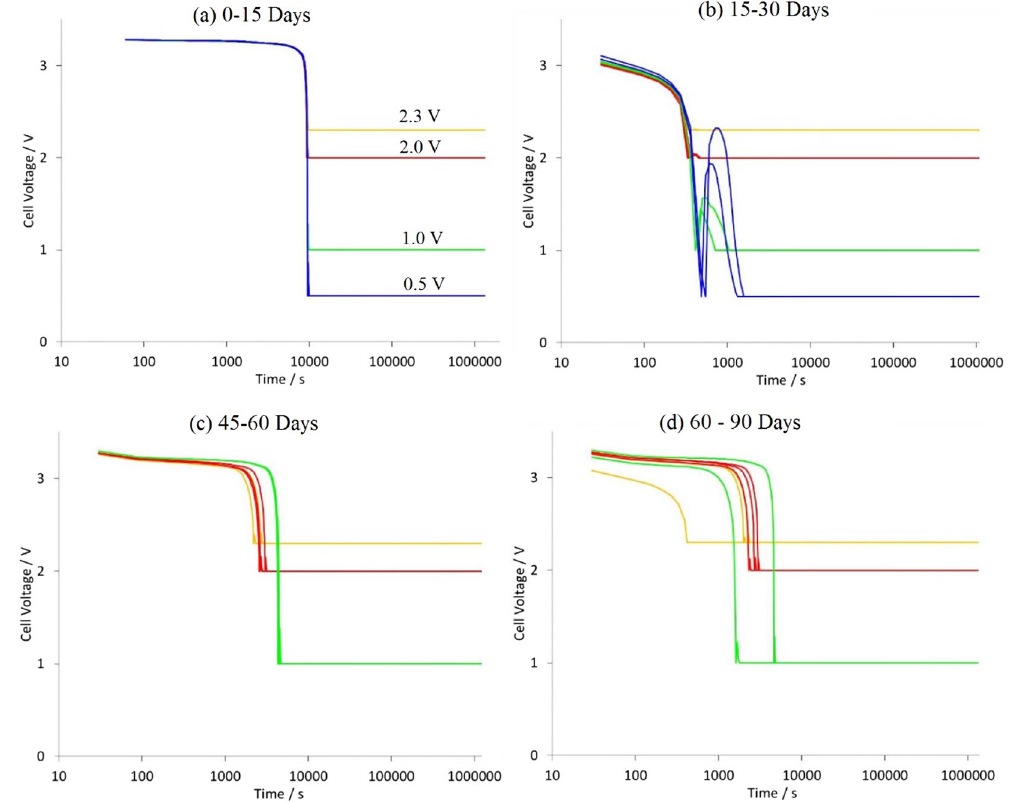
Figure 1. Discharge voltage and constant voltage storage for all cells. Cells stored at 0.5 V became dysfunctional after 30 days.